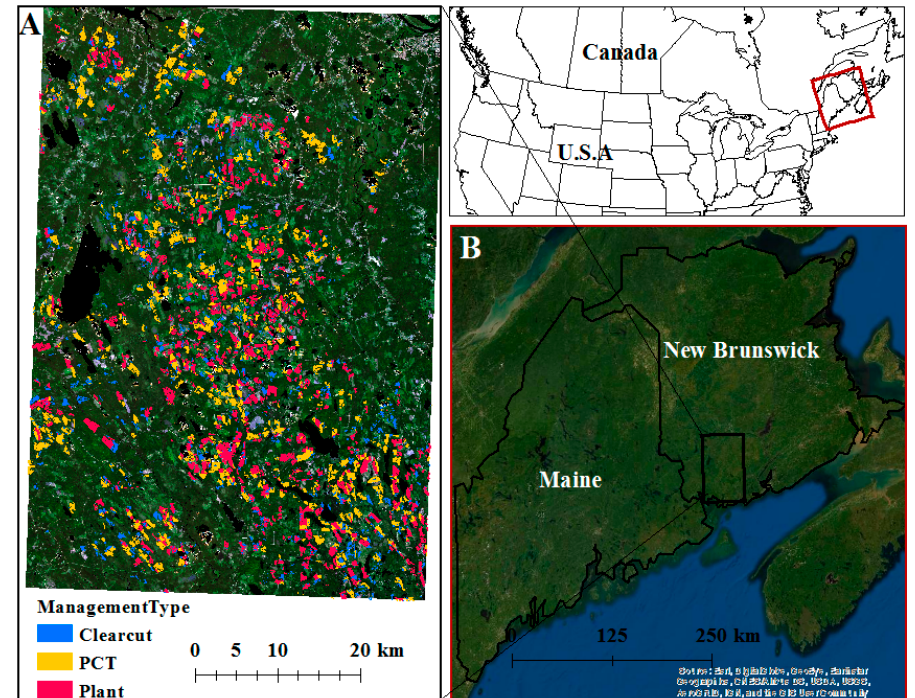
Figure 2. Extents of the study sites used for variable selection ( A ) and model creation and application ( B ). PCT: pre-commercial thinning, Plant: plantation.